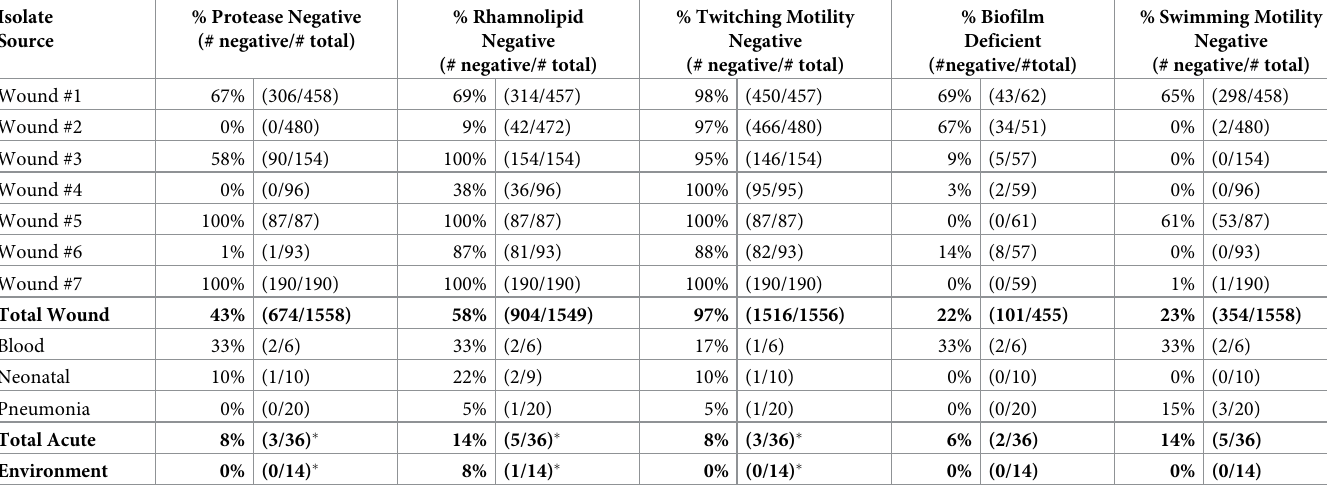
Table 1. Virulence and biofilm functions are often inactive in wound